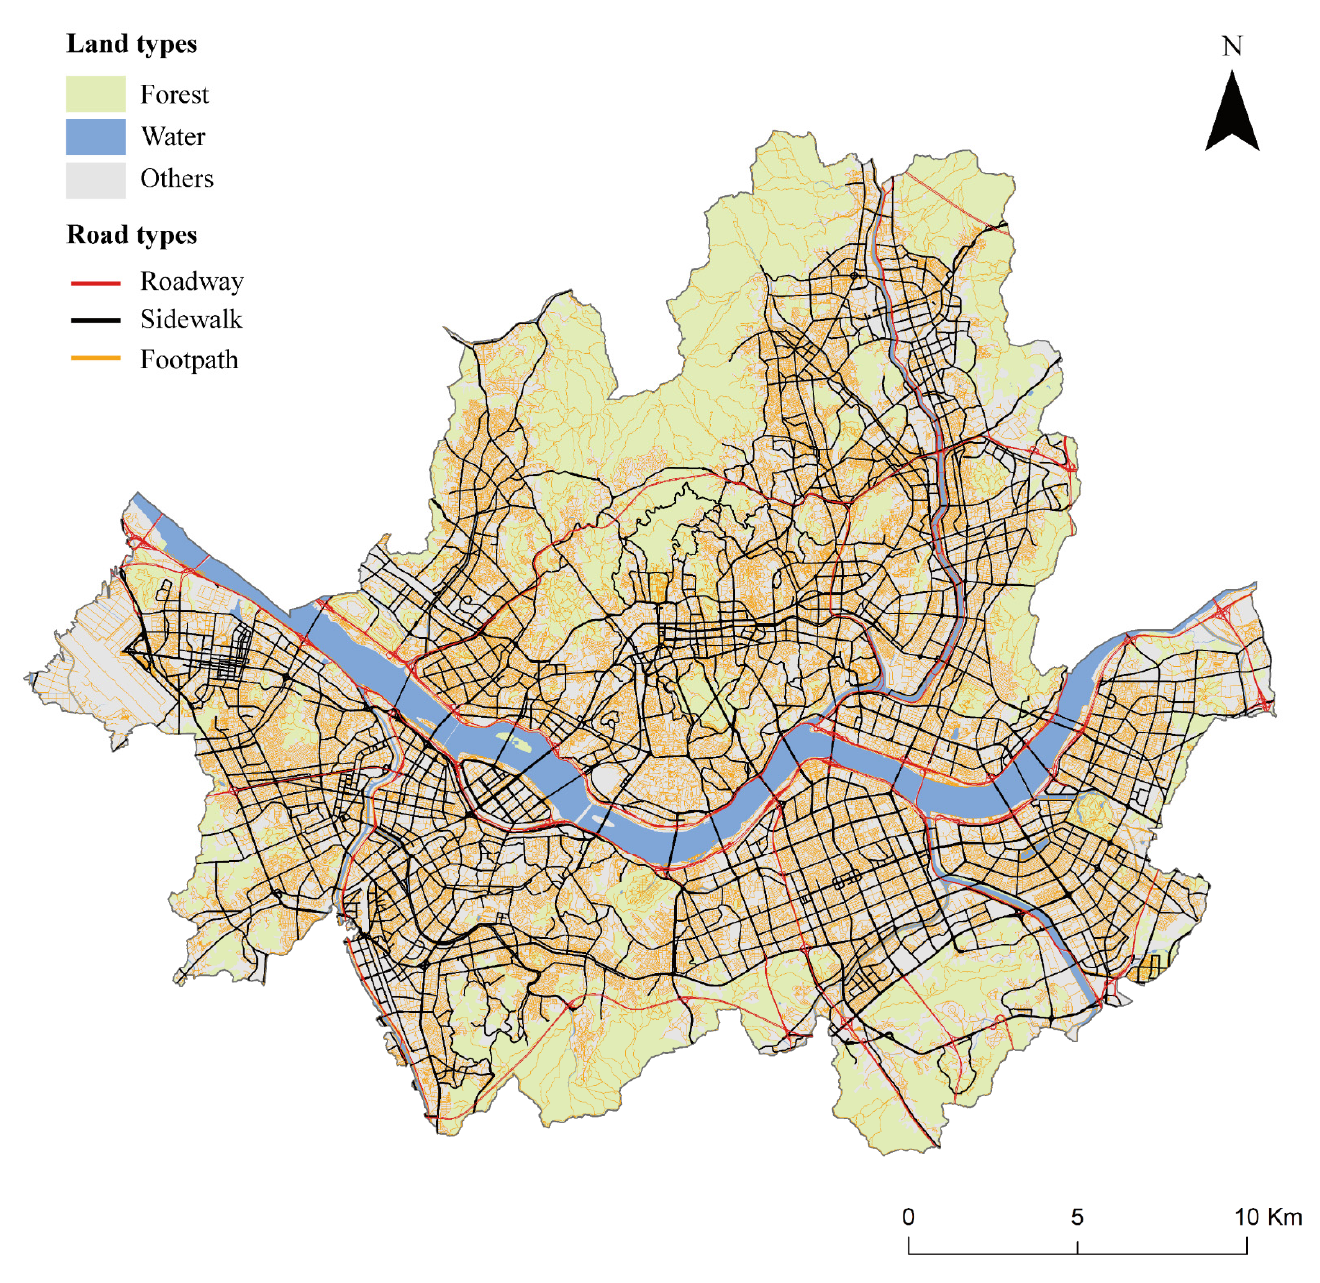
Figure 1. Map showing land cover and road types of study area, Seoul. A roadway is defined as a road specifically for vehicles. A sidewalk is defined as a road that has a roadway for vehicles and paths for pedestrians on the sides. A footpath is defined as a road that is shared by pedestrians and vehicles or used solely by pedestrians.